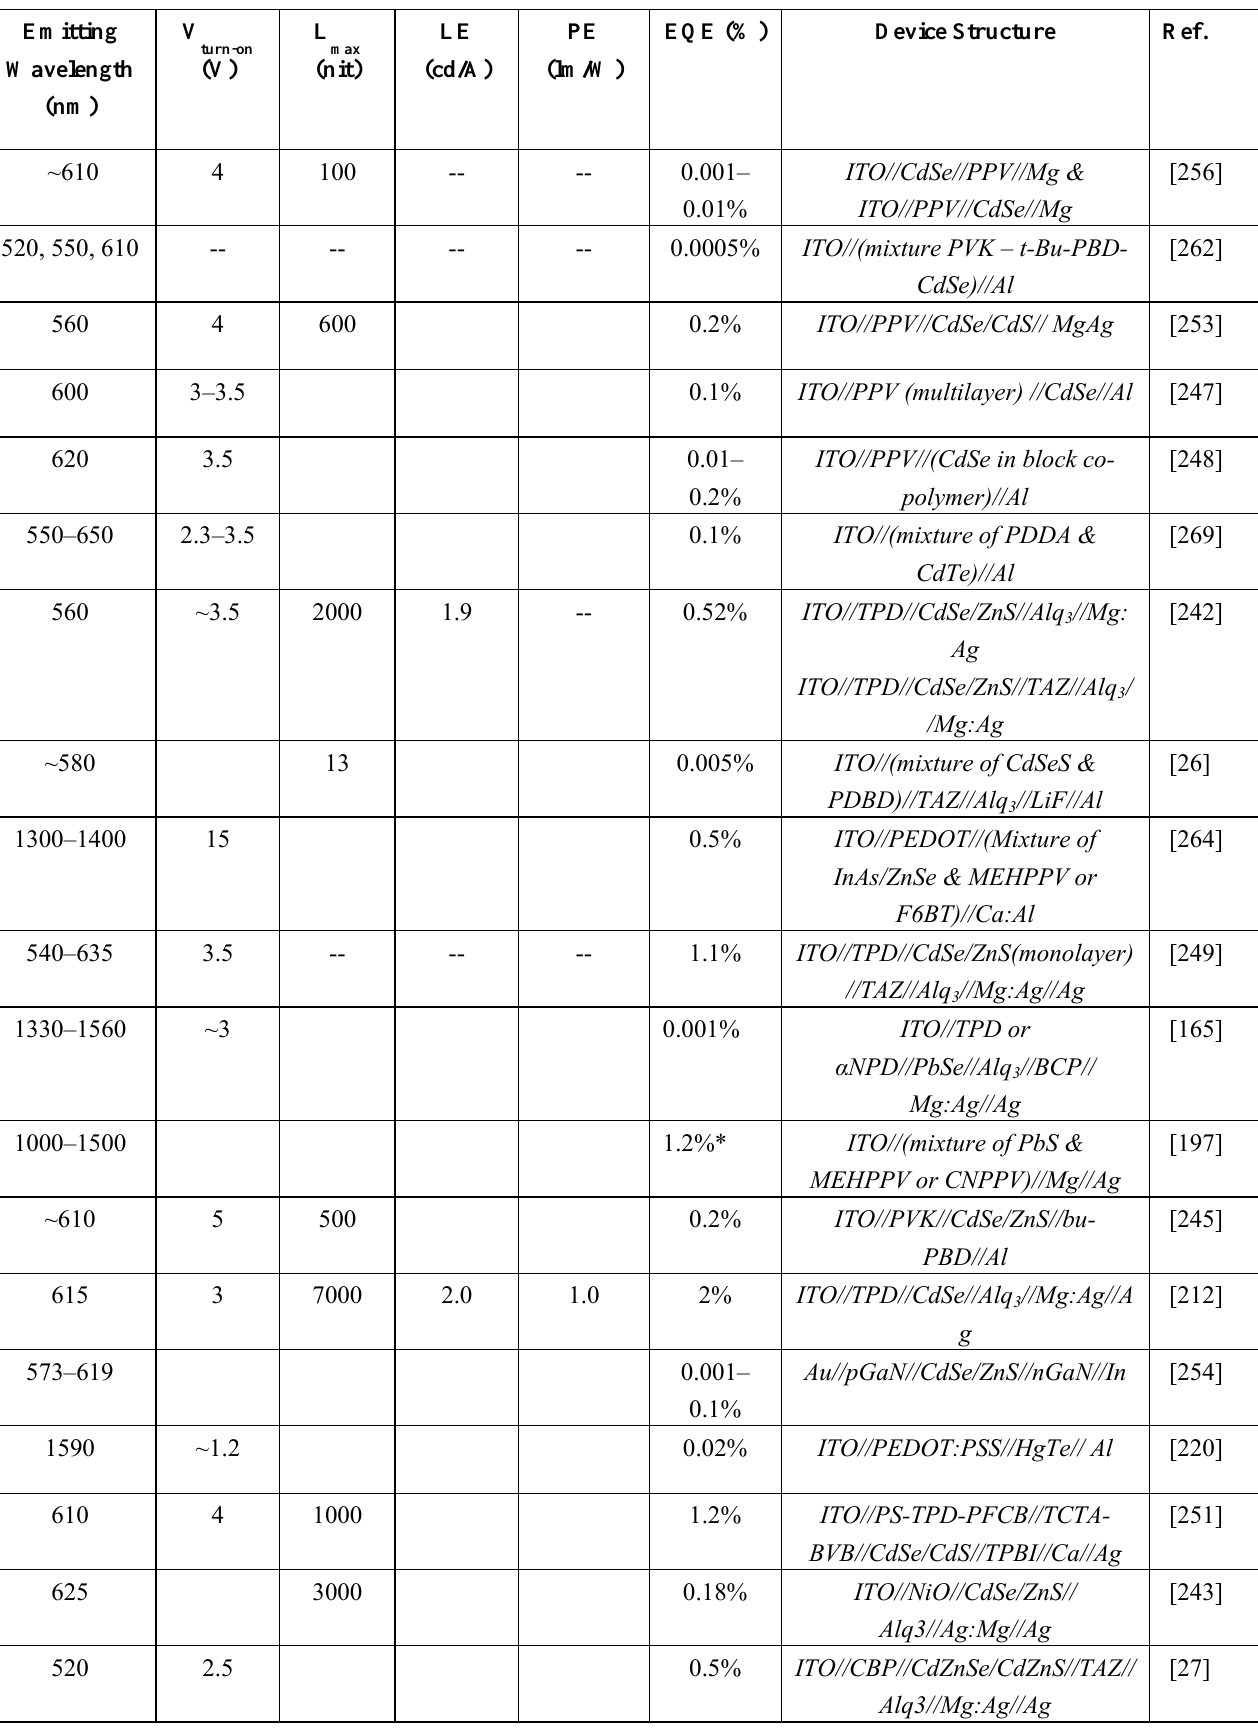
Table 7. Literature reported QLED device structures and their efficacy